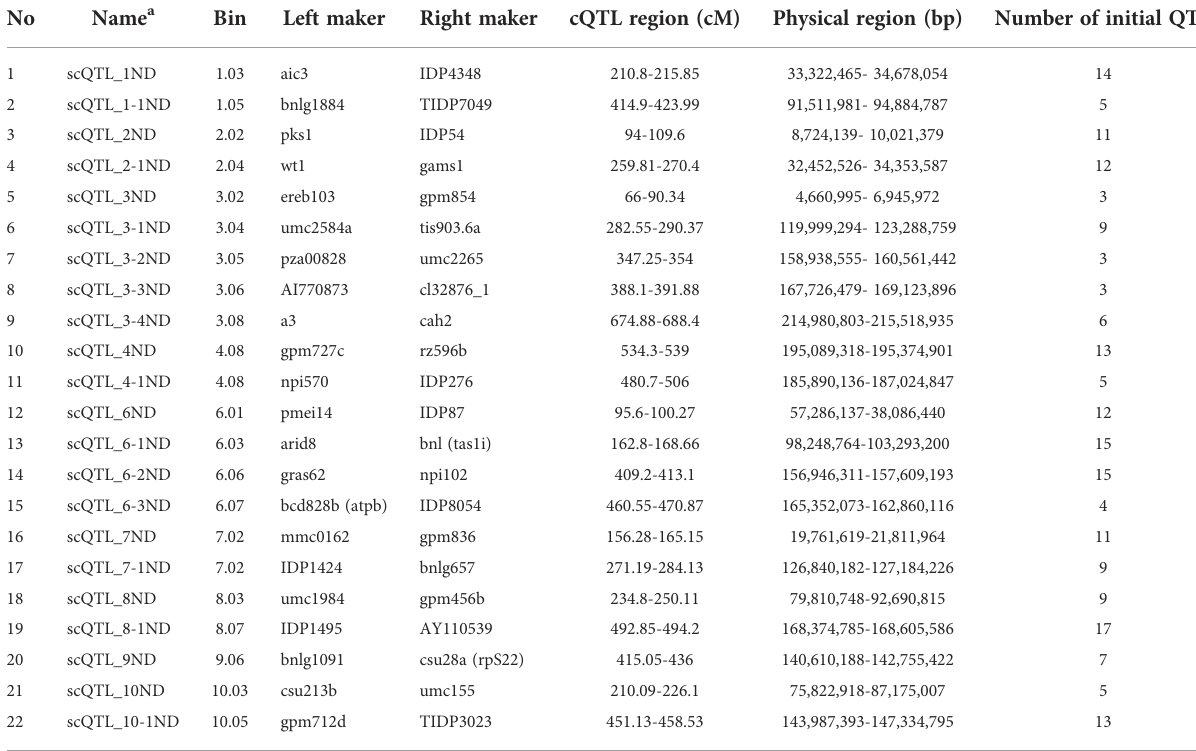
TABLE 1 The information of the 22 scQTLs.